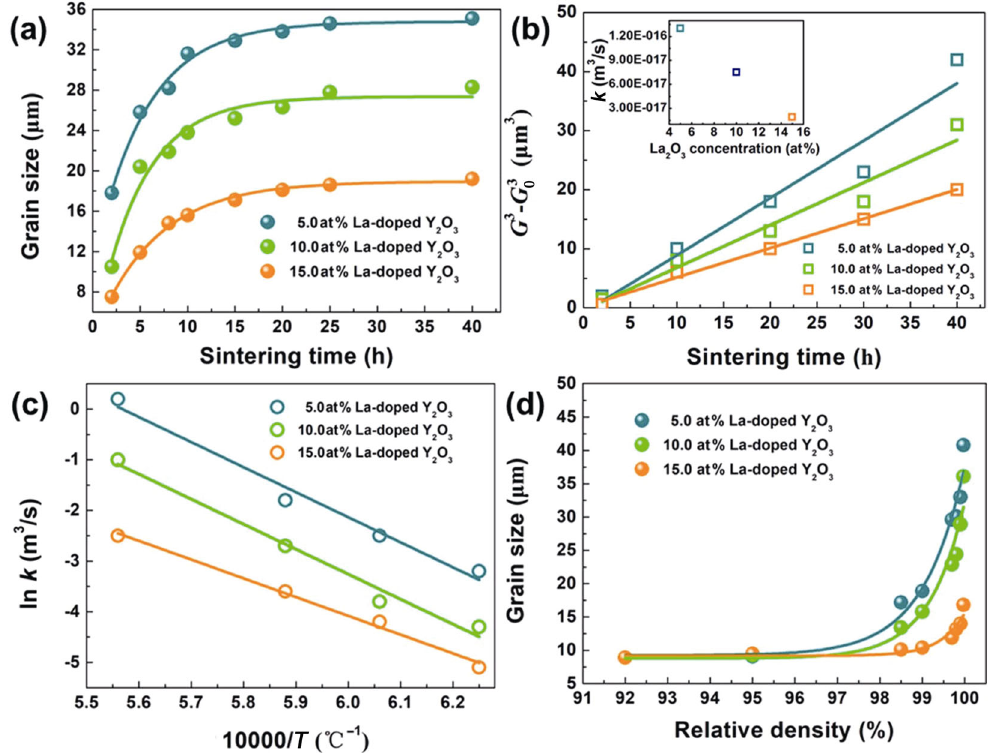
Fig. 4 (a) Grain size and (b) grain growth kinetics as a function of the sintering time for La-doped Y 2 O 3 ceramics at a sintering temperature of 1750 ℃ . (c) Arrhenius analysis of samples at a sintering temperature of 1650–1800 ℃ for 2–10 h. (d) Grain size vs. relative density of samples at a sintering temperature of 1750 ℃ for 2–40 h. Table 1 Mechanical properties and sound wave velocities of La-doped Y 2 O 3 ceramics La concentration